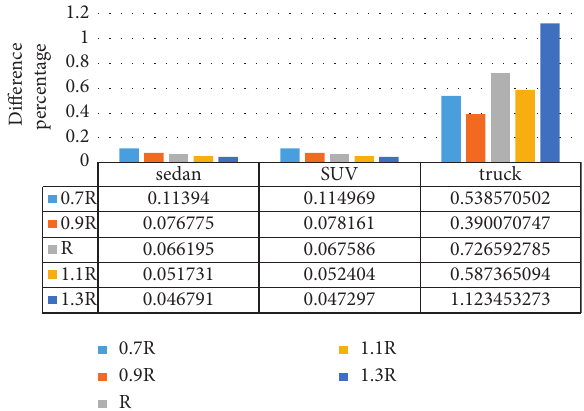
Figure 5: Difference percentage between the maximum side friction coefficients in the simple and spiral horizontal curves.